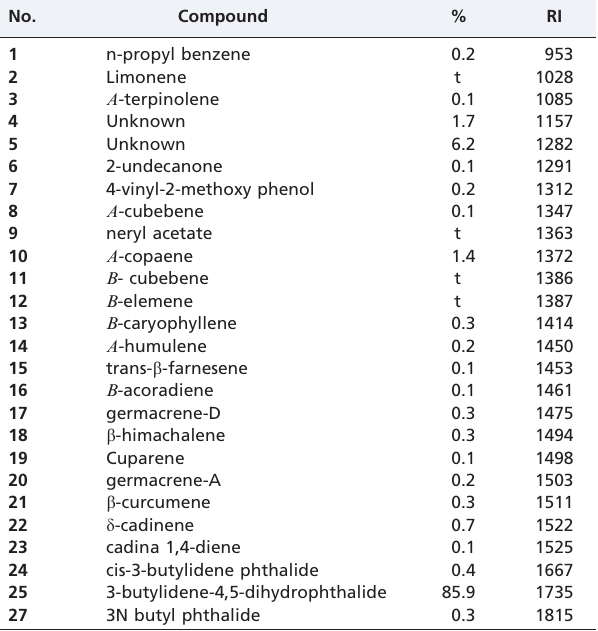
Table 1 - Percentage composition of the essential oil from K. odoratissima leaf analyzed by